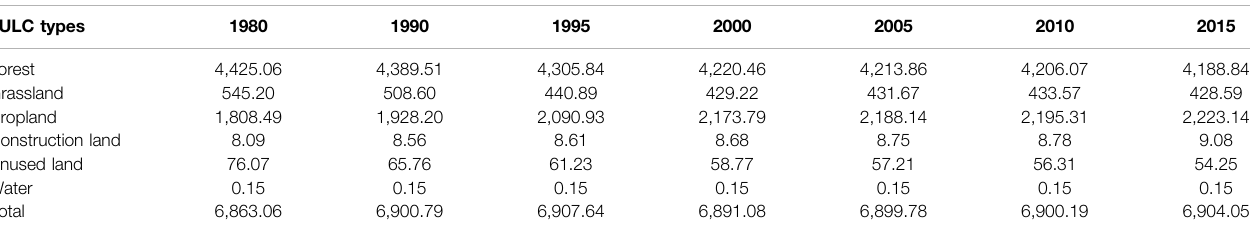
TABLE 4 | Carbon storage in different LULC type from 1980 to 2015 in Heilongjiang Province, Northeast China (×10 6 Mg). LULC